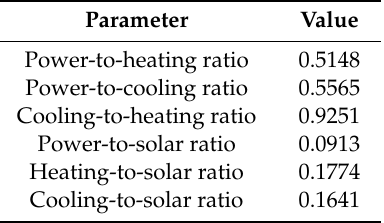
Table 5. Important ratio values of the yearly energy